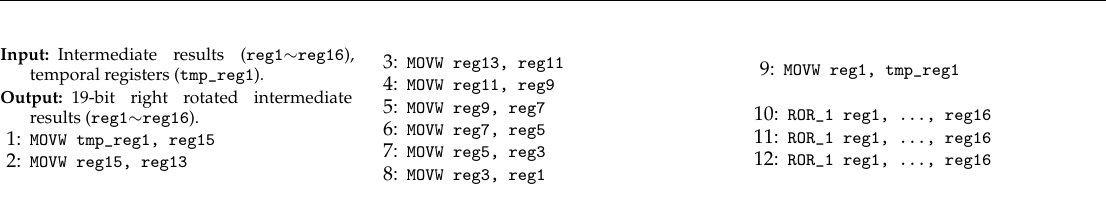
Algorithm 5 ROR_19 : 19-bit right rotation for 128-bit data.